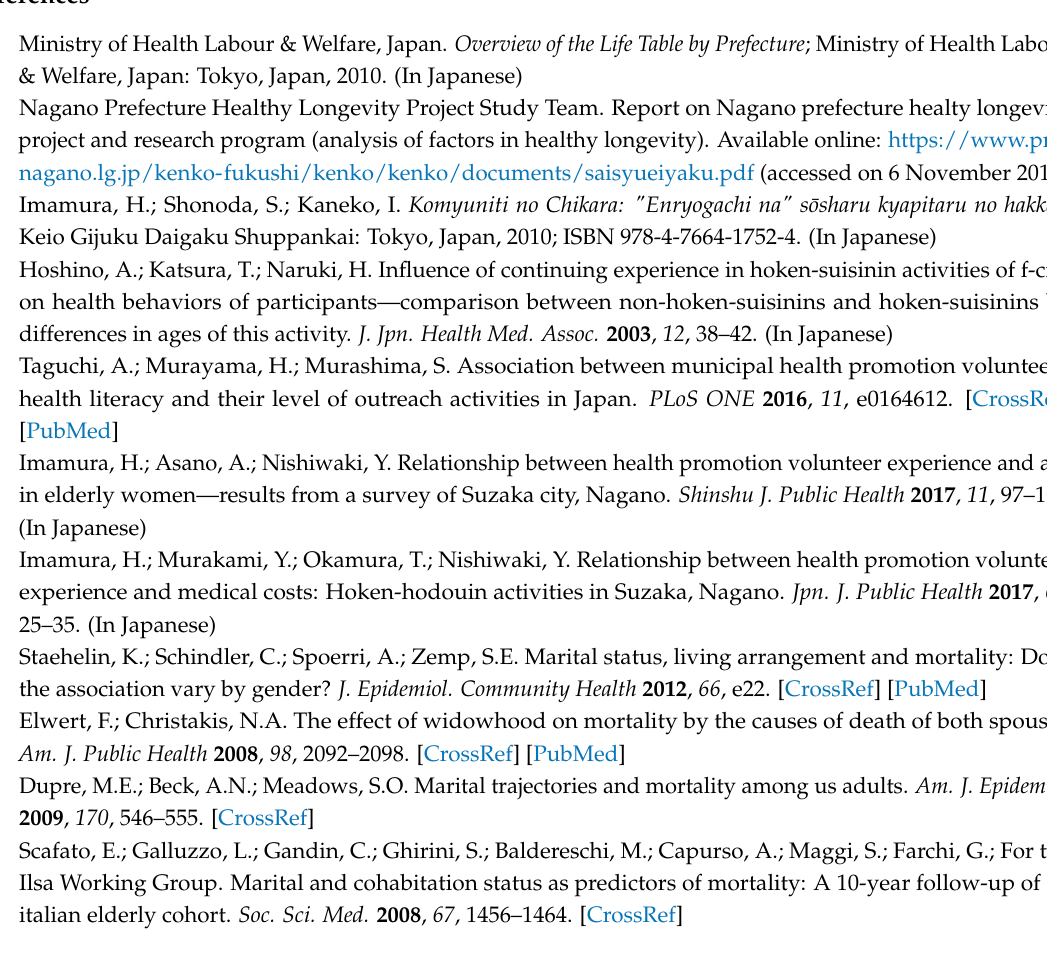
Table S1: Association between cohabiting women’s experience as a health promotion volunteer and low functional capacity (12 points or less) in the study population, Table S2: Associations between cohabiting women’s experience as a health promotion volunteer and both outcomes in the study population when narrowing the age of cohabiting women, Table S3: Associations between cohabiting women’s experience as a health promotion volunteer and both outcomes in the study population when not limiting the age of cohabiting women, Table S4: Associations between cohabiting women’s experience as a health promotion volunteer and depressive symptoms in the study population when limiting the health status of cohabiting women to not having depressive